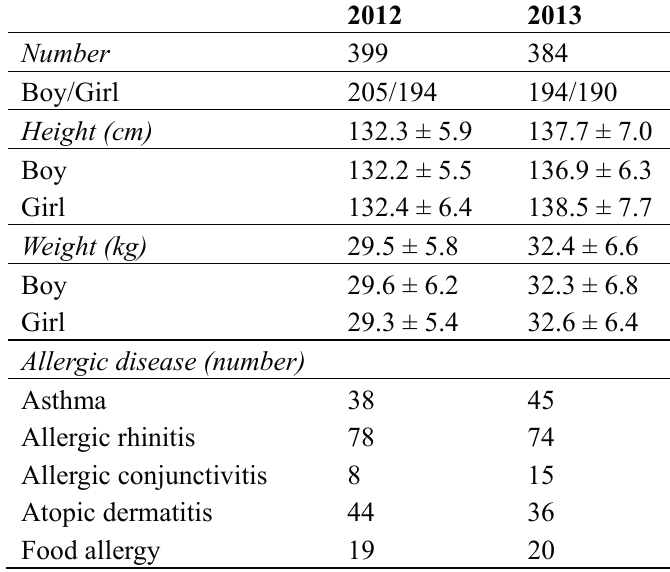
Table 1. Characteristics of the schoolchildren included in the